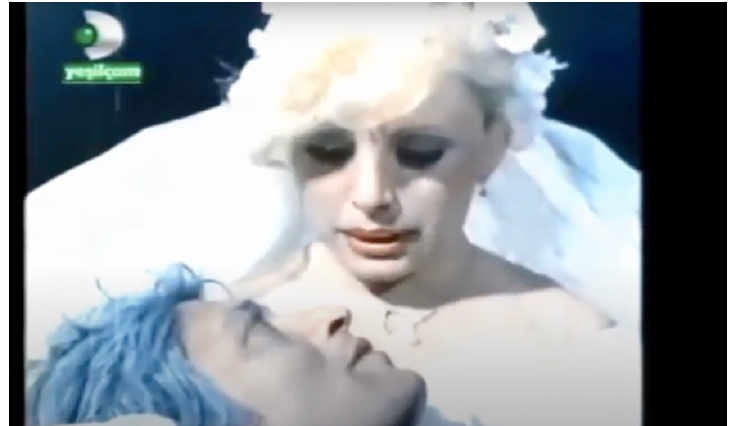
Figure 4: Adnan’s death scene